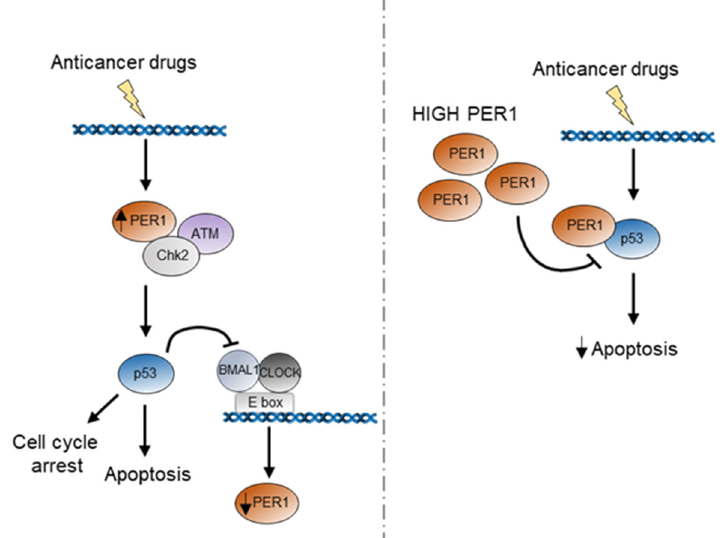
Figure 5. Schematic representation of the potential role of PER1 during p53 activation in response to anticancer treatment. In the first hours following anticancer treatment, PER1 is induced and takes part to the activation of the DNA damage response through binding and induction of the ATM-Chk2 checkpoint kinases. The subsequent activation of p53 determines a repression of PER1 expression. Indeed, high levels of PER1 reduce the stability of p53 and determine a repression of p53-mediated apoptosis, ultimately leading to reduced sensitivity of cancer cells to chemotherapy treatment.